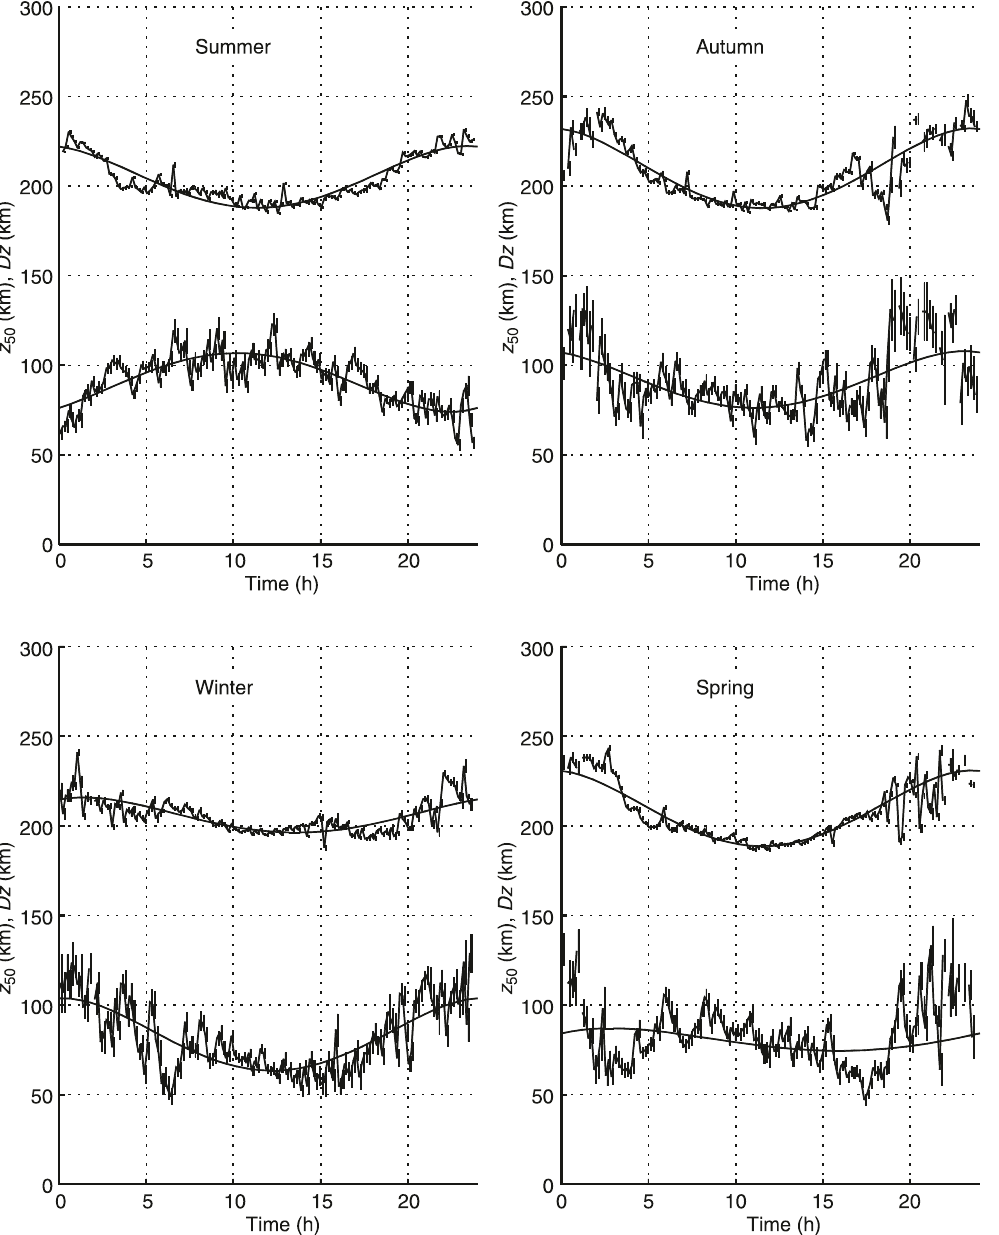
Fig. 4. As for Fig. 3 but for high solar